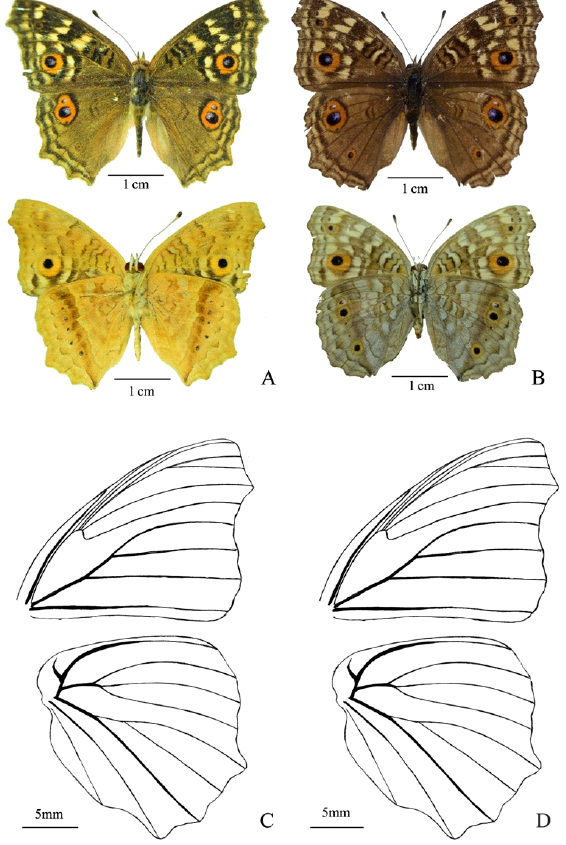
Figure 7. Junonia lemonias (Linnaeus, 1758) A - male (dry season form); B - female (wet season form); C - wing venation (male); D - wing venation